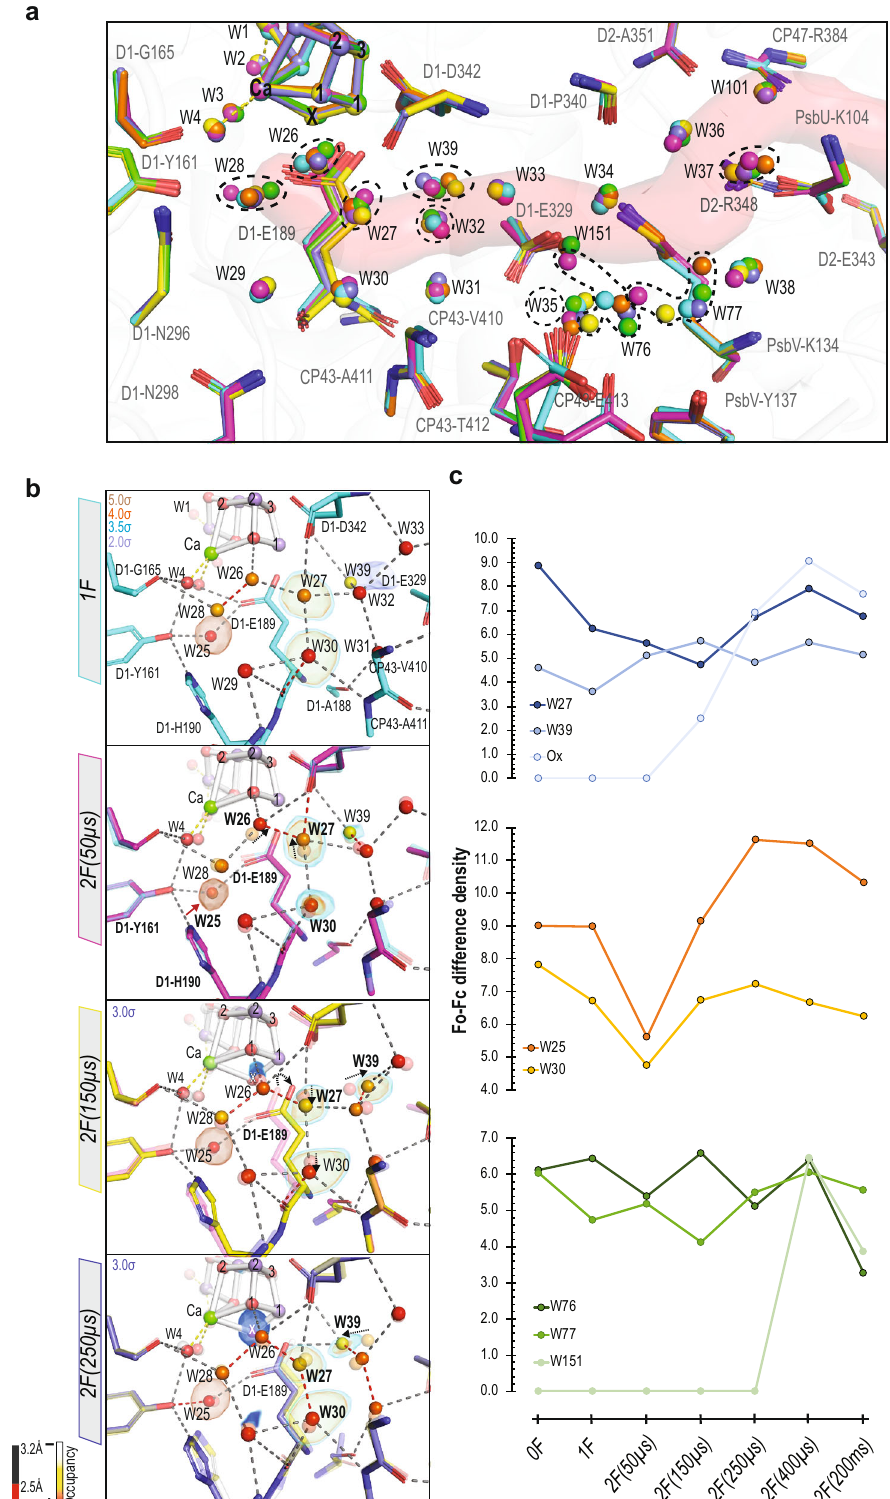
signi fi cant decrease in electron density and occupancy of W27 2 F(50µs) is accompanied by a drop of electron density of two were observed at 2 F(150µs) and the W39 electron density waters, W25 and W30, that are hydrogen-bonded to D1-E189 increases to reach its maximum at this time point (Fig. 3b, c). (Fig. 3b, c). W25 is additionally H-bonded to Yz and W3. This decrease and increase of the electron density at W27 and Among the waters in the O1 channel, the position of waters W39 coincide with the starting of the Ox density build-up at the that are in close proximity to the OEC (W26, W27, W28, and open coordination site of Mn1. Among the four ligand waters W39), change the most during the S 2 to S 3 transition (Fig. 3a). A NATURE COMMUNICATIONS| (2021) 12:6531